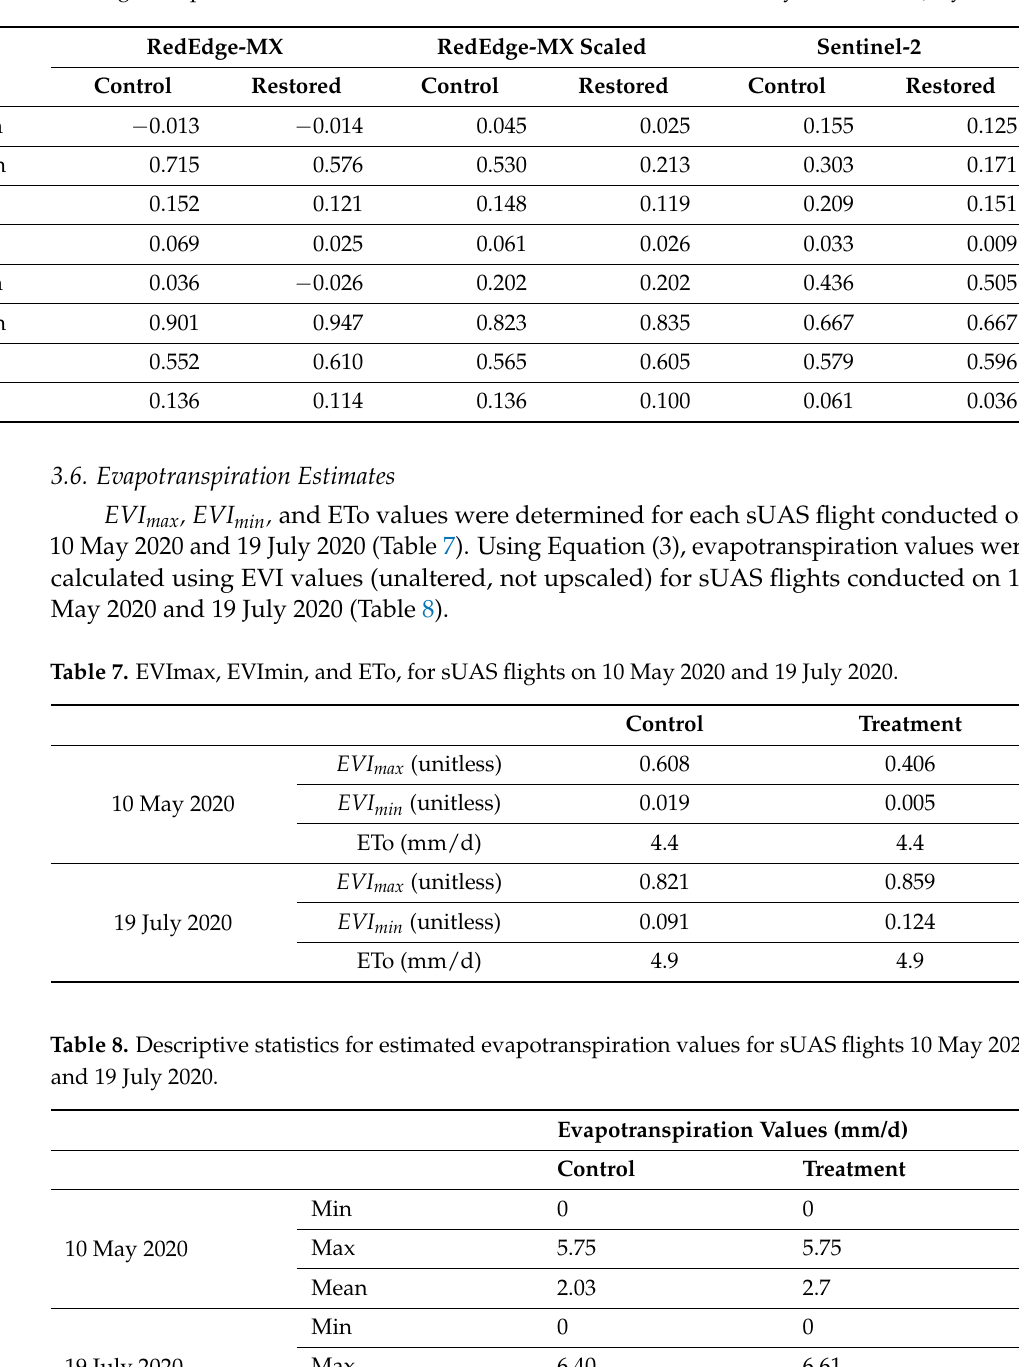
Table 6. Comparison of EVI values, calculated using ArcMap, between the RedEdge-MX, the